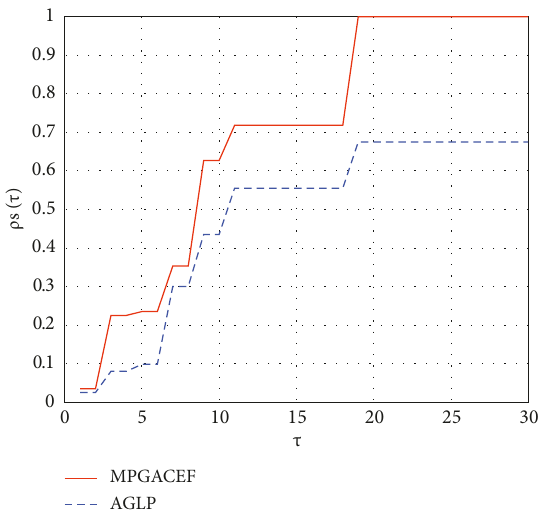
Figure 3: Performance of NIT Time for MPGACEF and AGLP under the condition of CVRP50.